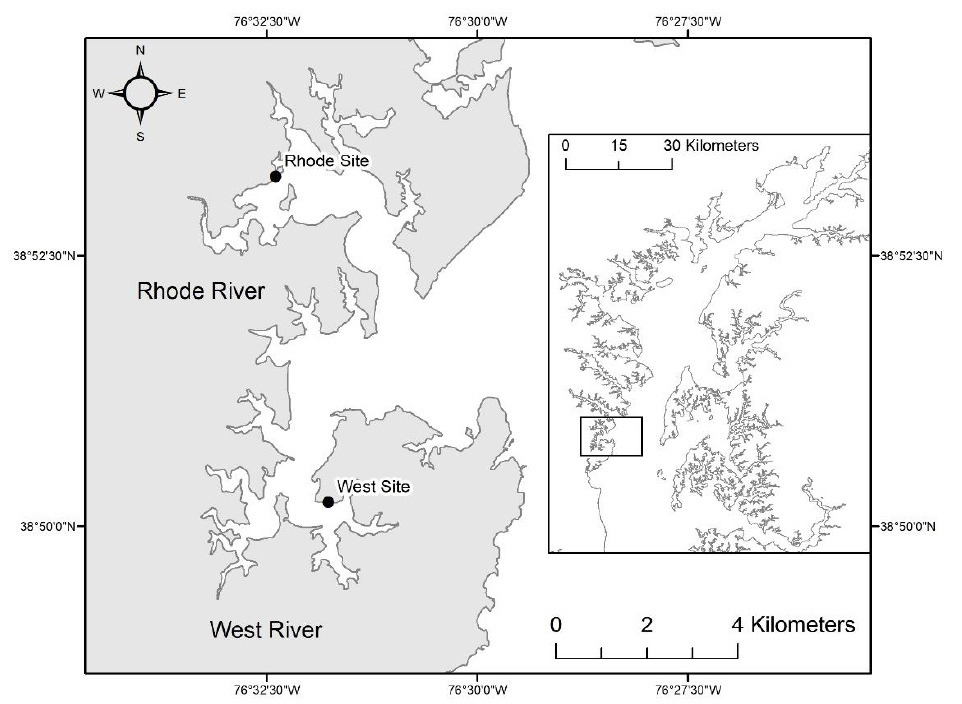
Figure 1. Map of field study sites in the Rhode and West Rivers, Chesapeake Bay.